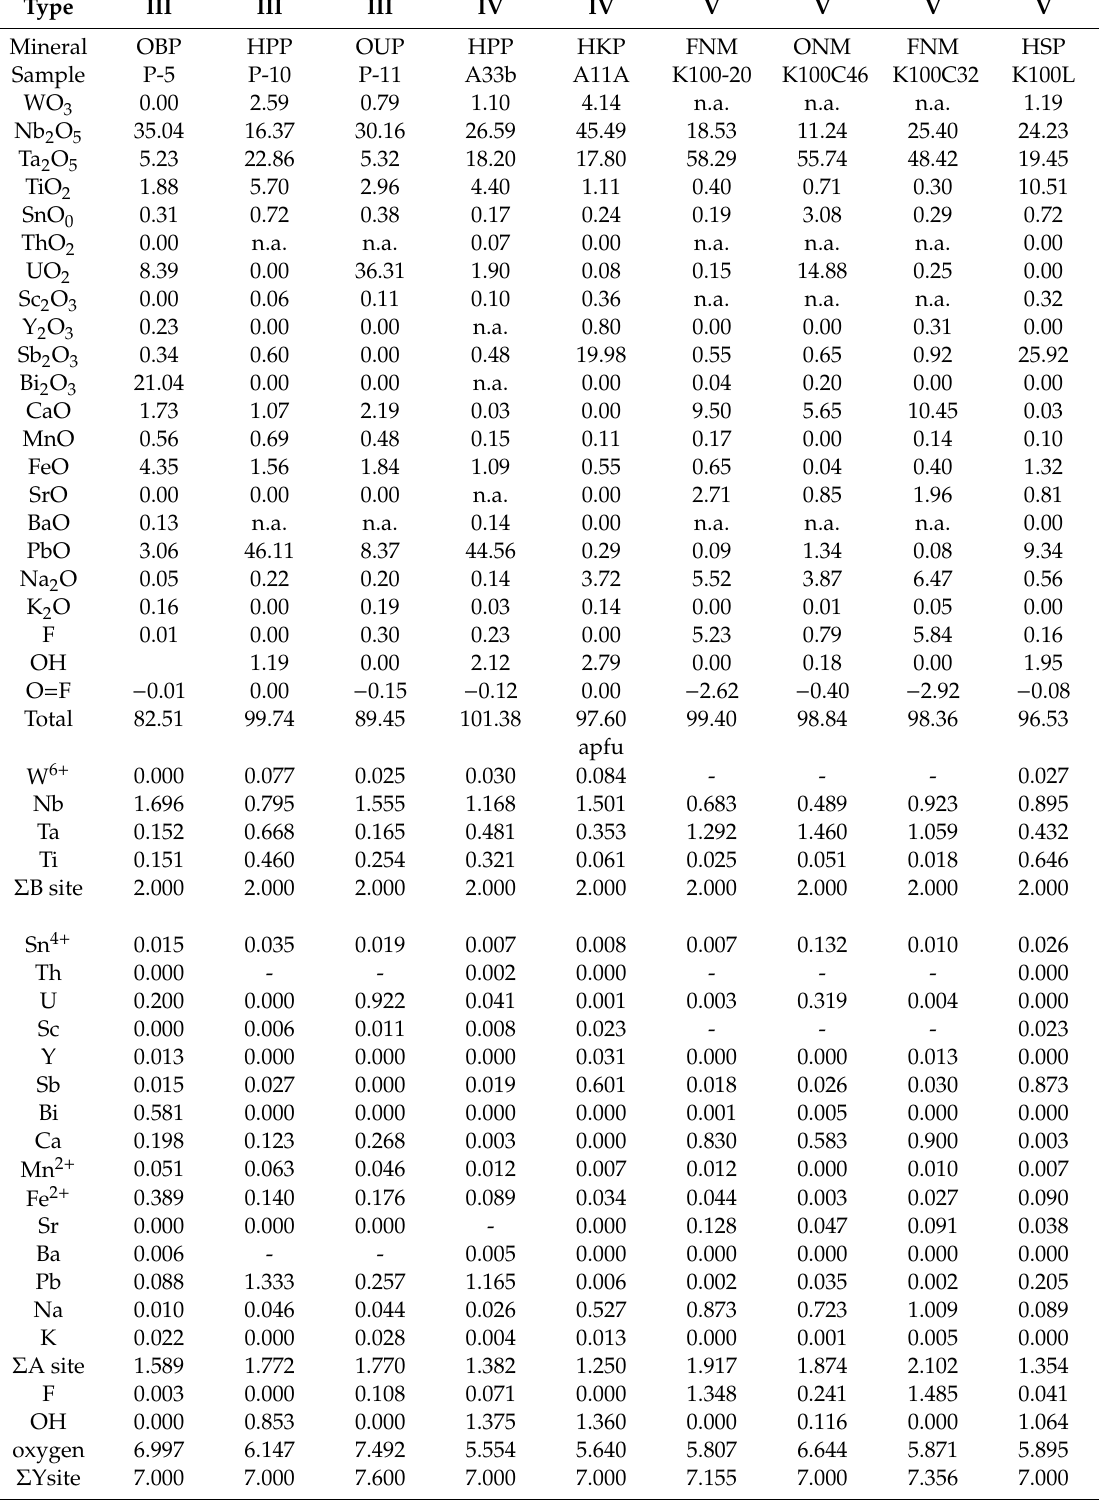
Table 3. Chemical composition, wt.%, of pyrochlore-supergroup minerals from the Gira ú l pegmatites. Type Mineral